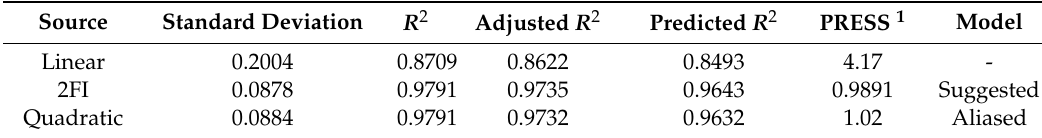
Table 5. Statistics analysis to select the fitting model for Ra.